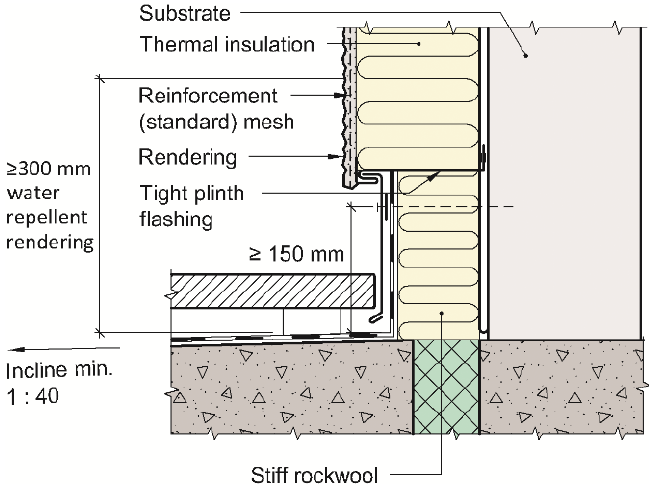
Figure 8. Example of a moisture-resistant wall finishing against a balcony.